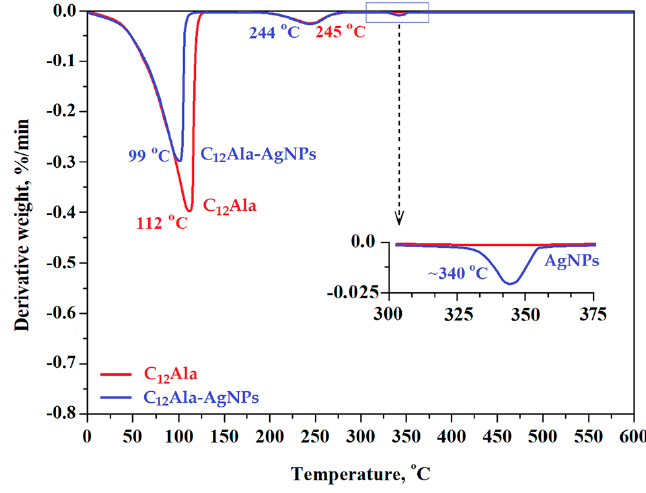
Figure 9. Temperature dependence of the derivative of weight loss on the heating rates of C 12 Ala and C 12 Ala-AgNPs gels.